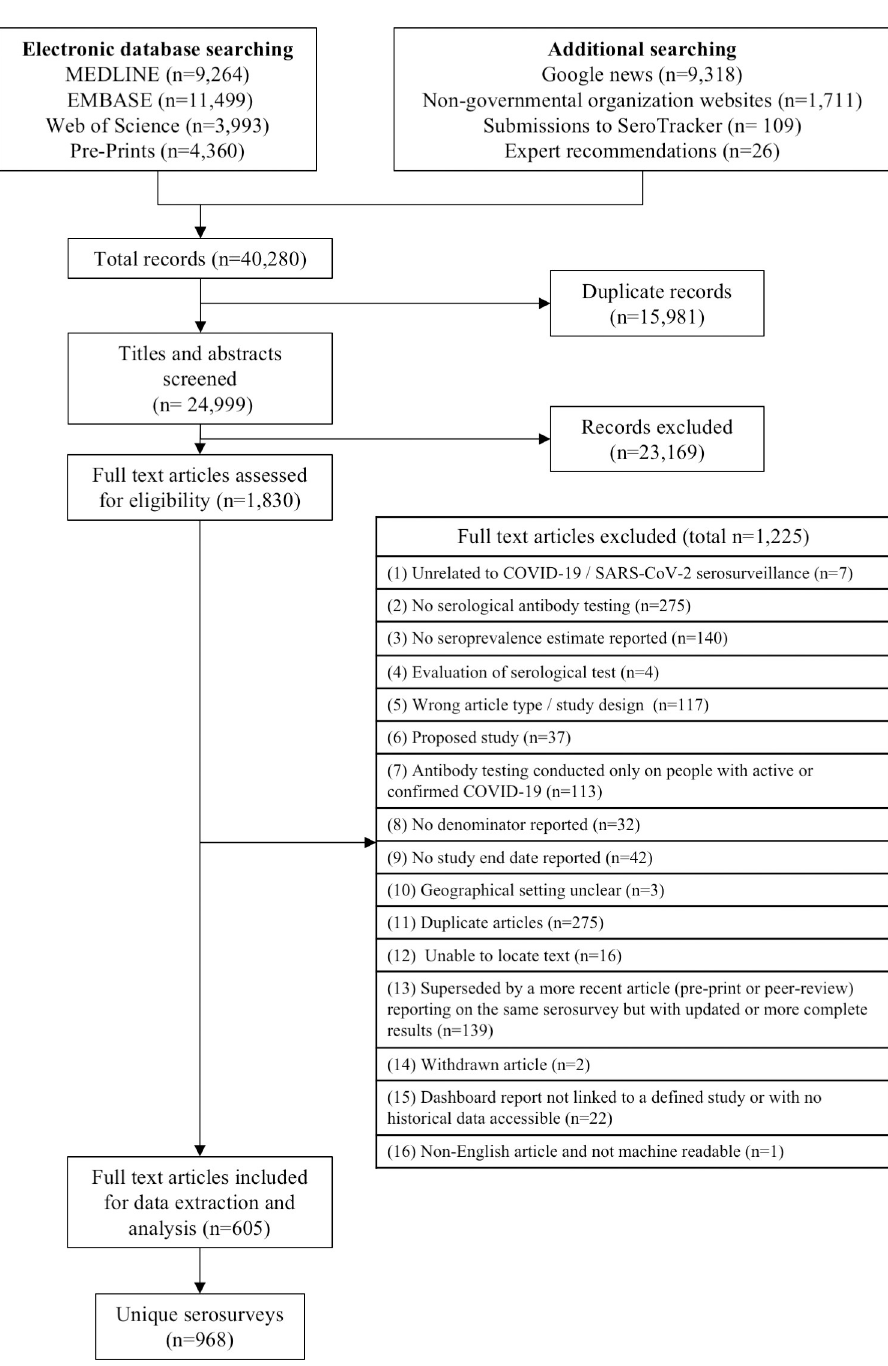
Fig 1. PRISMA flow diagram of study